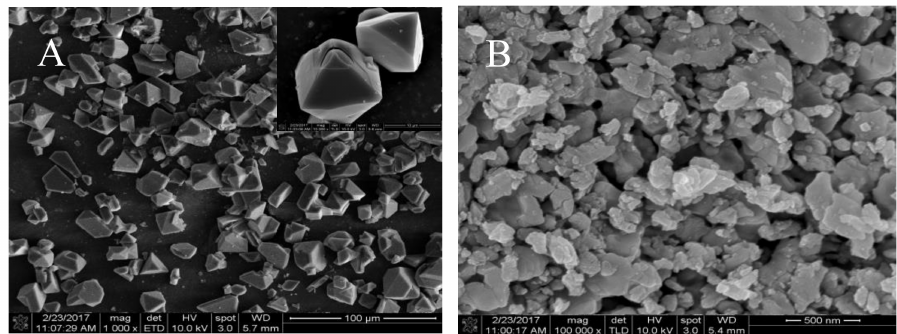
Figure 3. SEM images of HKUST-1( A ) and CuO-400( B ).